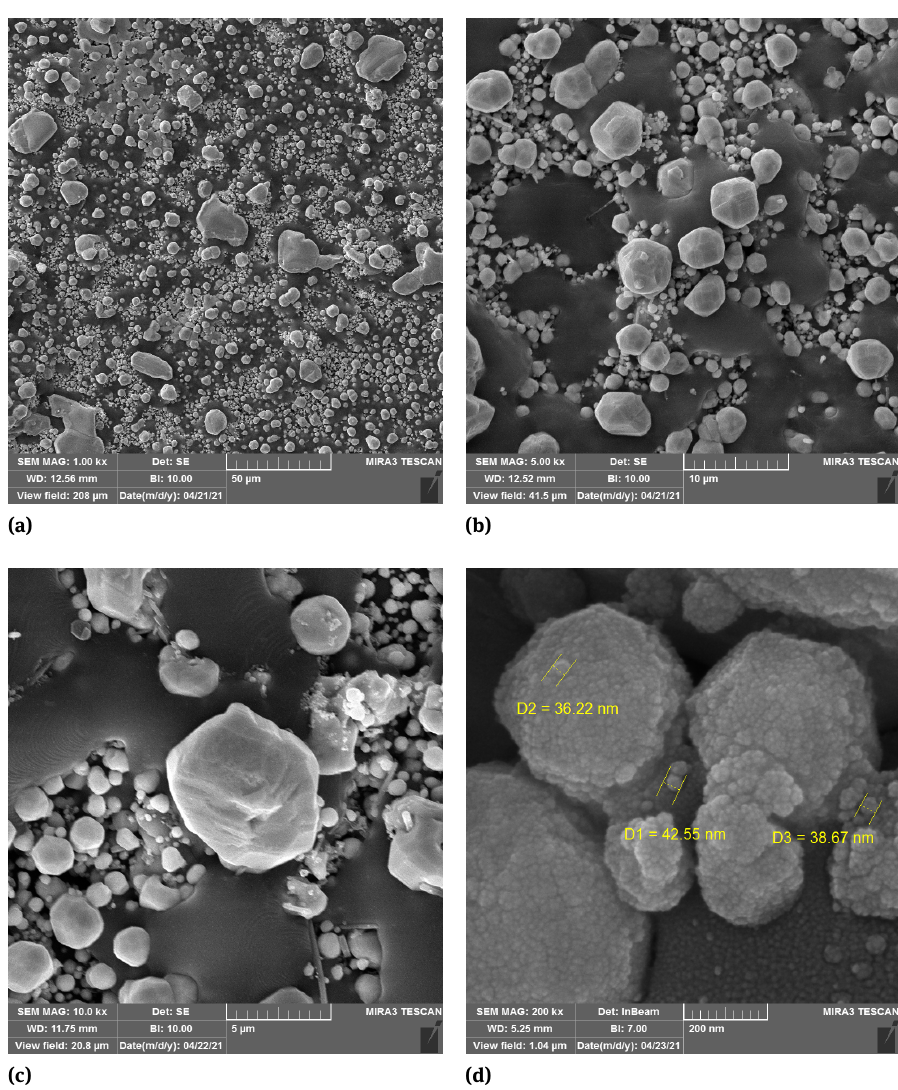
Figure 2: FE-SEM images describe the surface morphology and particle size of Ag 2 O NPs with four different magnifications (a) 1KX, (b) 5 KX, (c)10 KX, and (d) 200 KX.